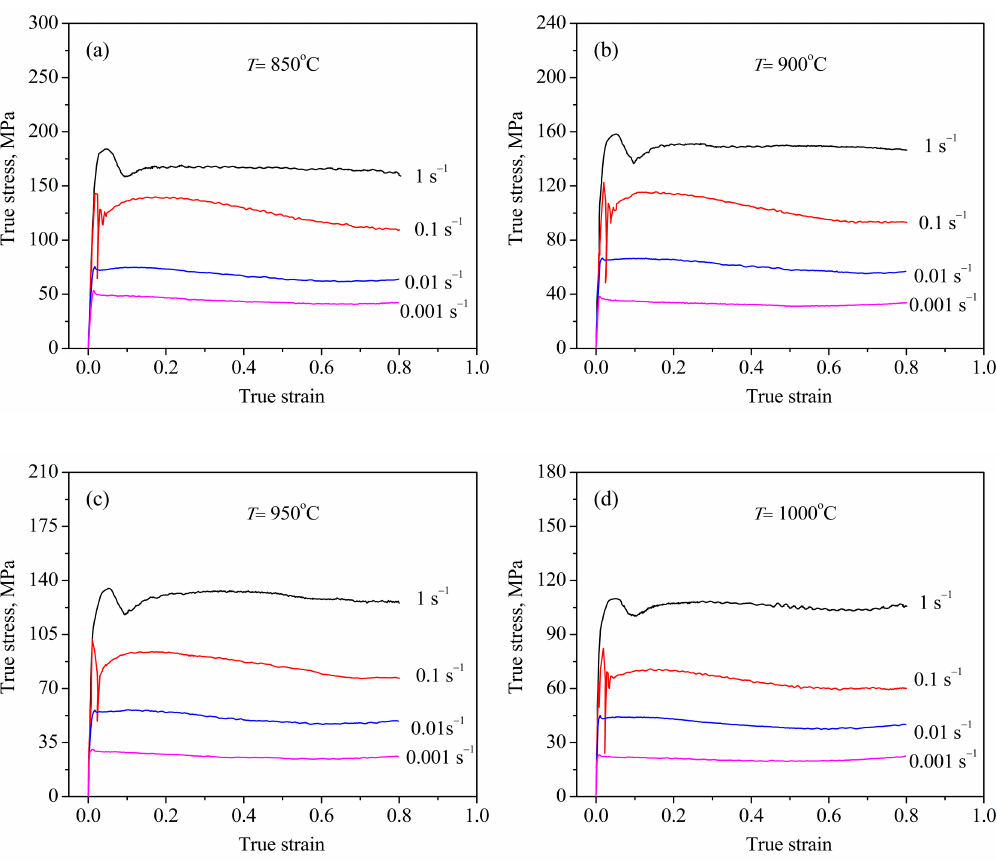
Figure 2. ( a – d ) Stress–strain curves of TB8 titanium alloys at di ff erent deformation Figure 2. Stress–strain curves of TB8 titanium alloys at different deformation conditions.